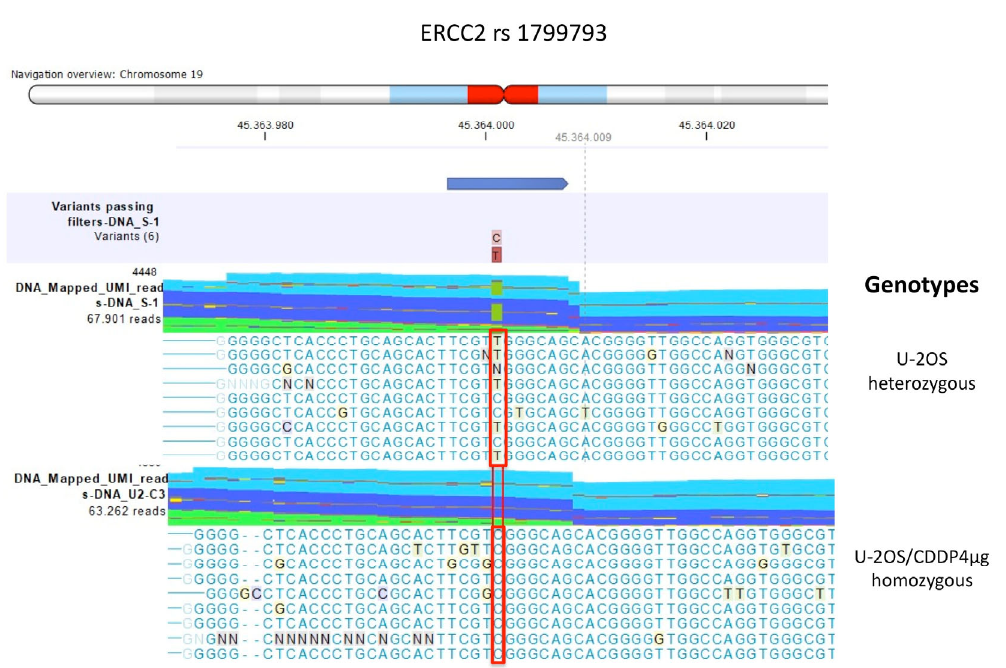
Figure 2. ERCC2 rs1799793 genotypes identified by multimodal targeted next generation sequencing (mmNGS) in U ‐ 2OS cell line and U ‐ 2OS/CDDP4 μ g variant. Mismatched nucleotides were evidenced by the CLC Genomics Workbench (GWB) with a background color according to the Rasmol color scheme. The red square box indicates the polymorphism alleles.